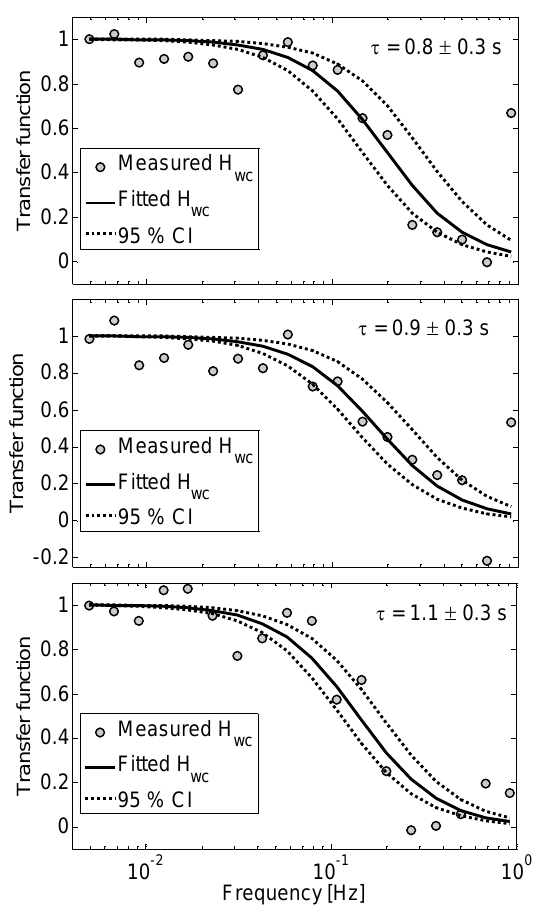
Figure 3. Transfer functions of H 3 O + H 2 O (37.0284 amu; top), H 3 O + (H 2 O) 2 (55.039amu; middle) and C 5 H 8 H + (69.0699amu; bottom). The circles are the measurements, the solid black line the fitted transfer function and the dashed lines are the 95% confidence intervals. The response time of the measurement system, τ , was cal- culated by fitting Eq. (10) to the